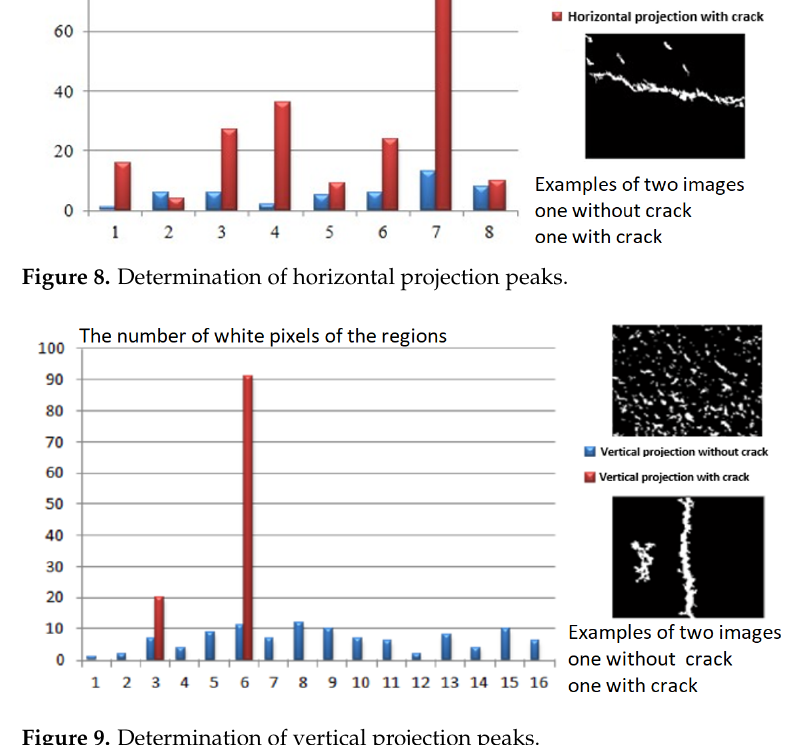
Figure 9. Determination of vertical projection